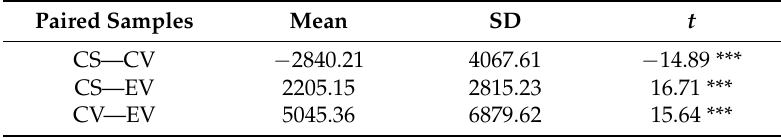
Table 11. Results of paired-sample t -test for the on-site Poisson model. Paired